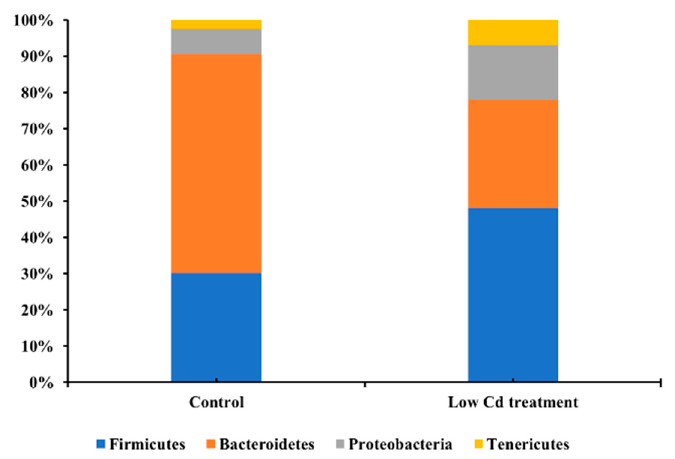
Figure 3. The relative abundance of predominant bacteria at the phylum level in the control and low Cd treatment groups.